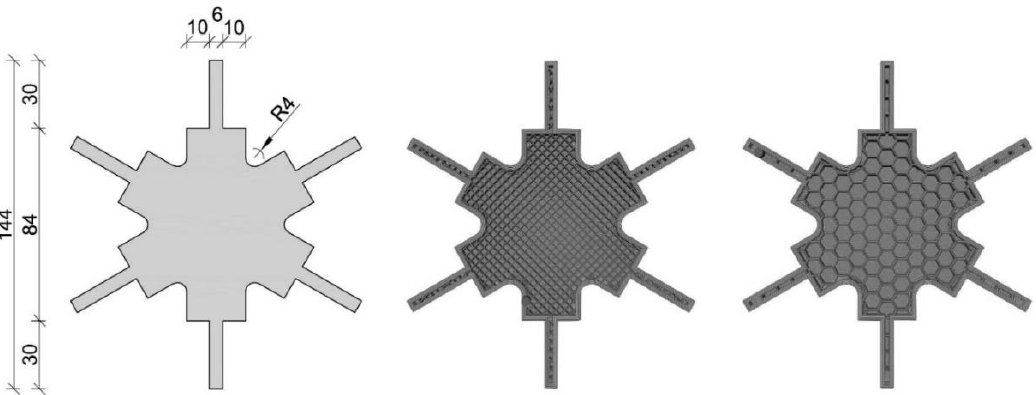
Figure 4. Top view of the design of the test knot ( left ), horizontal section of a specimen with 4 contour layers and 17% rectangular filling ( center ), horizontal section of a specimen with 4 contour layers and 17% honeycomb filling ( right ) [mm].